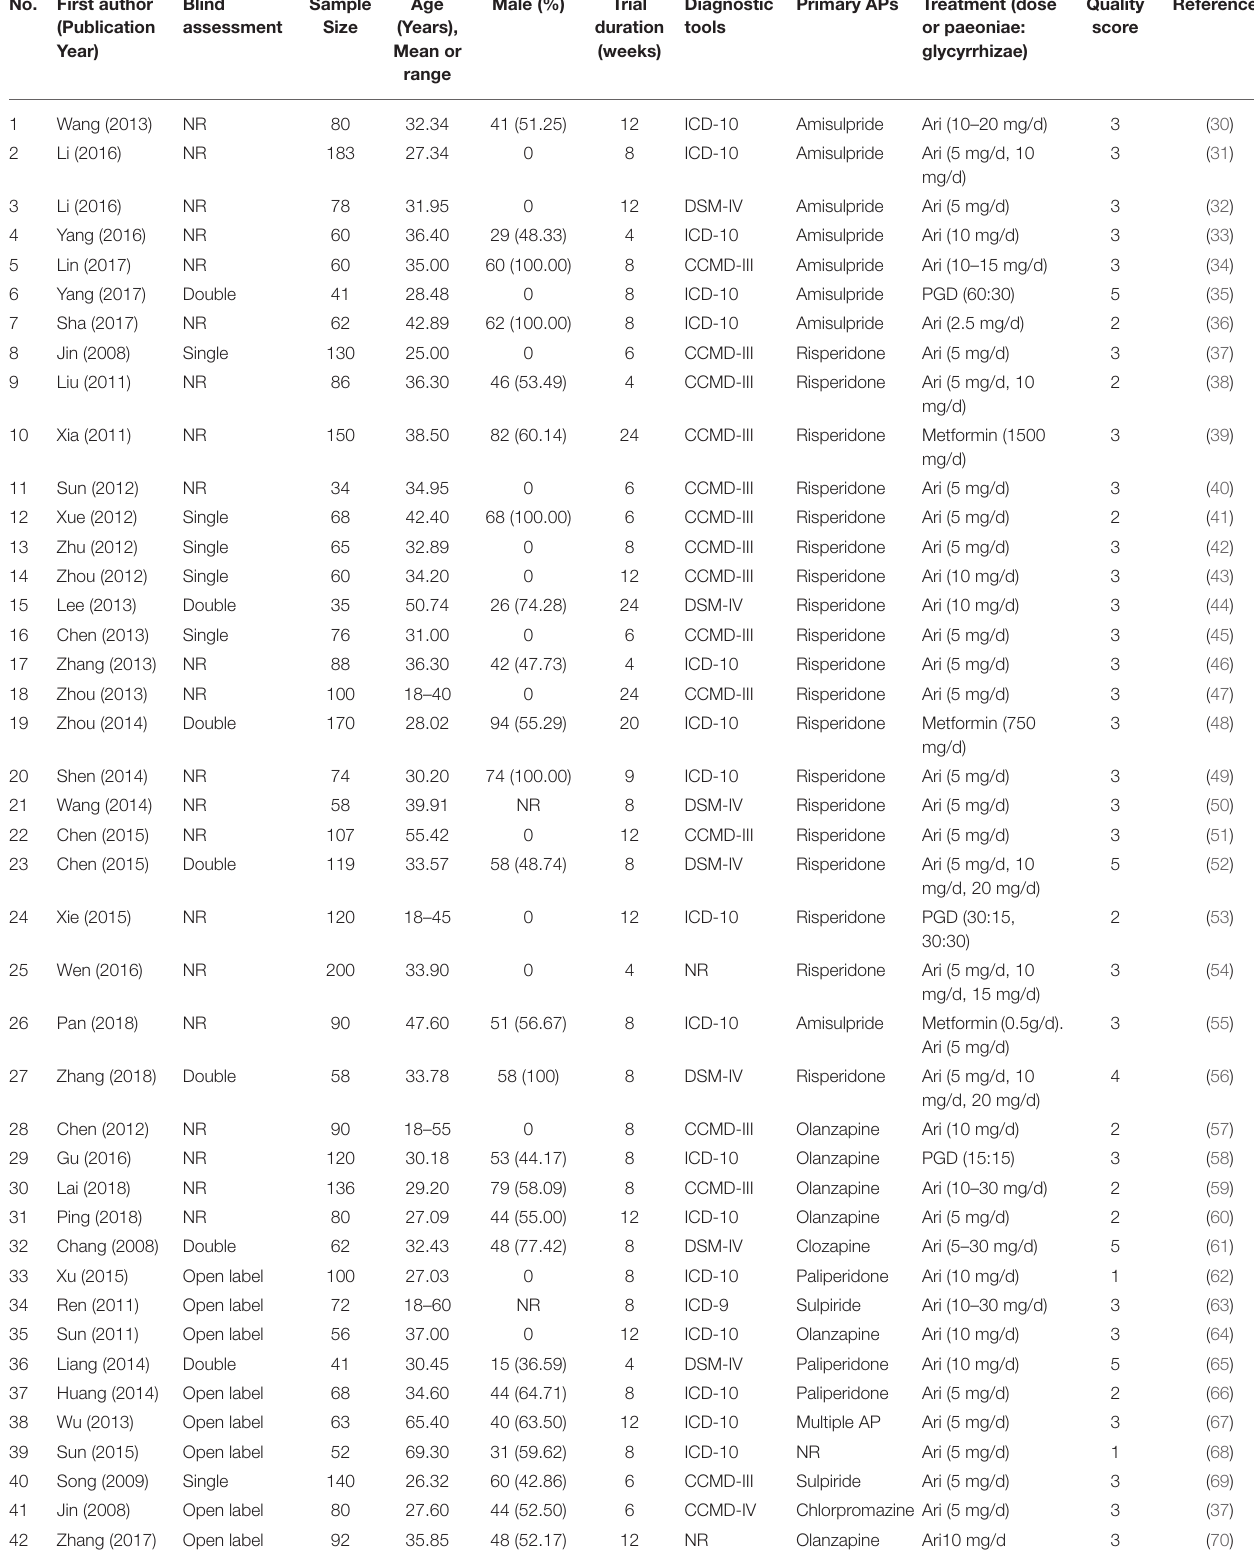
TABLE 1 | Characteristics of studies included in this